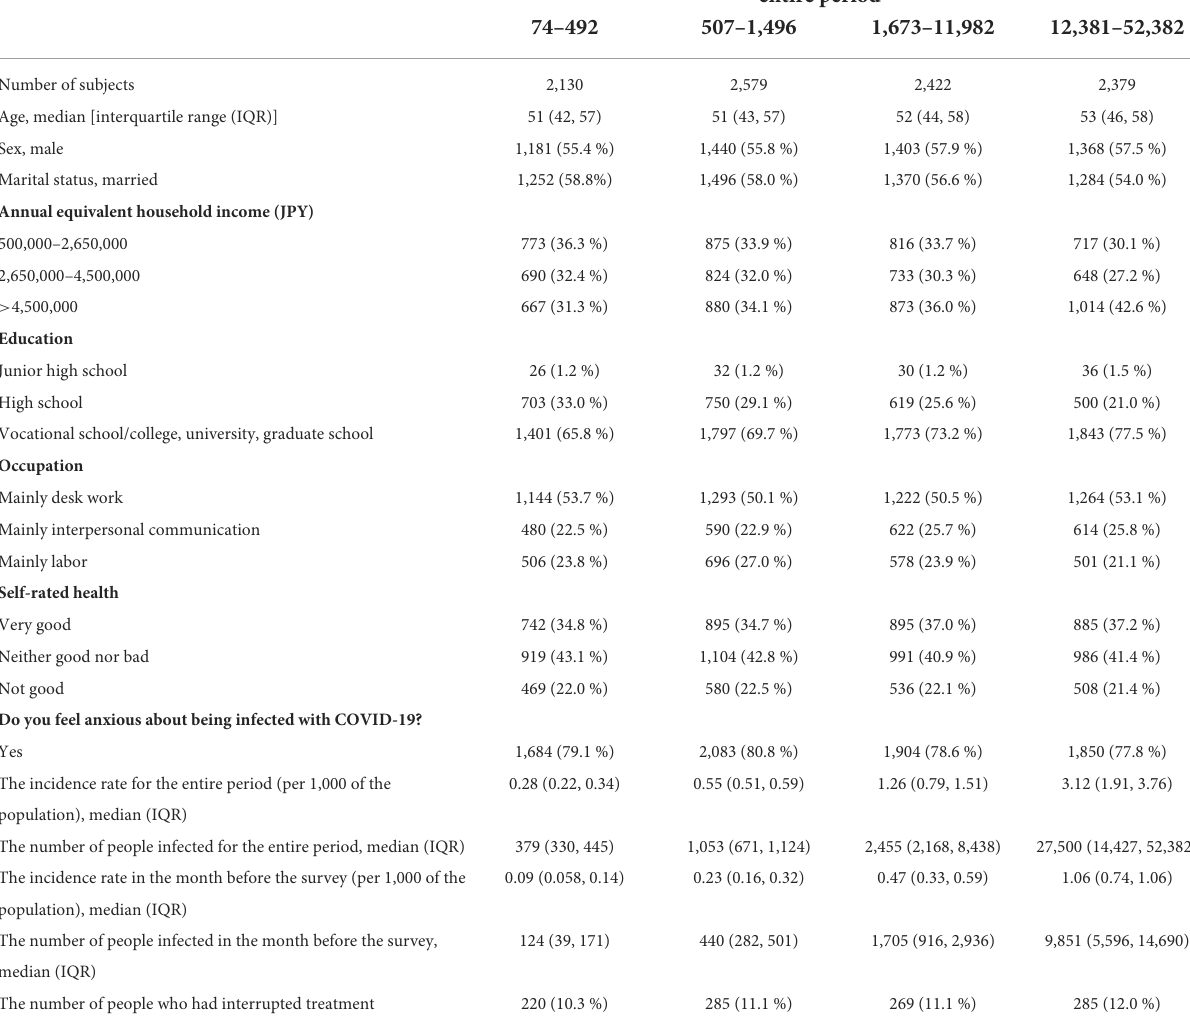
TABLE 1 Basic characteristics of the study